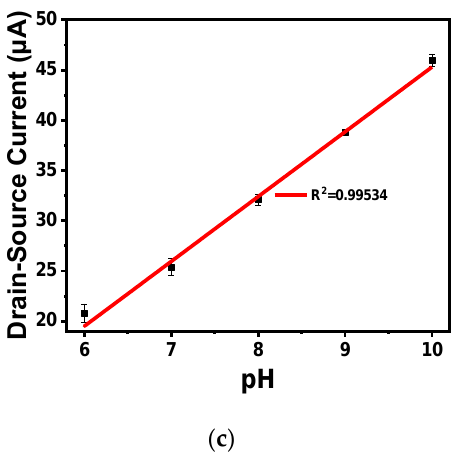
Figure 11. In 2 O 3 nanobelt ISFET pH detection: ( a ) I DS -V GS curve family with pH from 6 to 10; ( b ) linear curve of V GS -pH from 6 to 10; ( c ) linear curve of I DS -pH from 6 to 10.